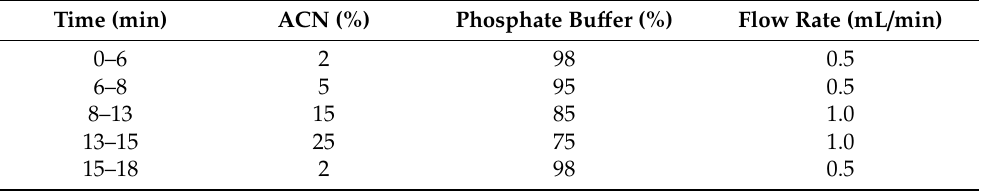
Table 6. Gradient conditions for the elution of THCl and NA in simulated saliva (SS).